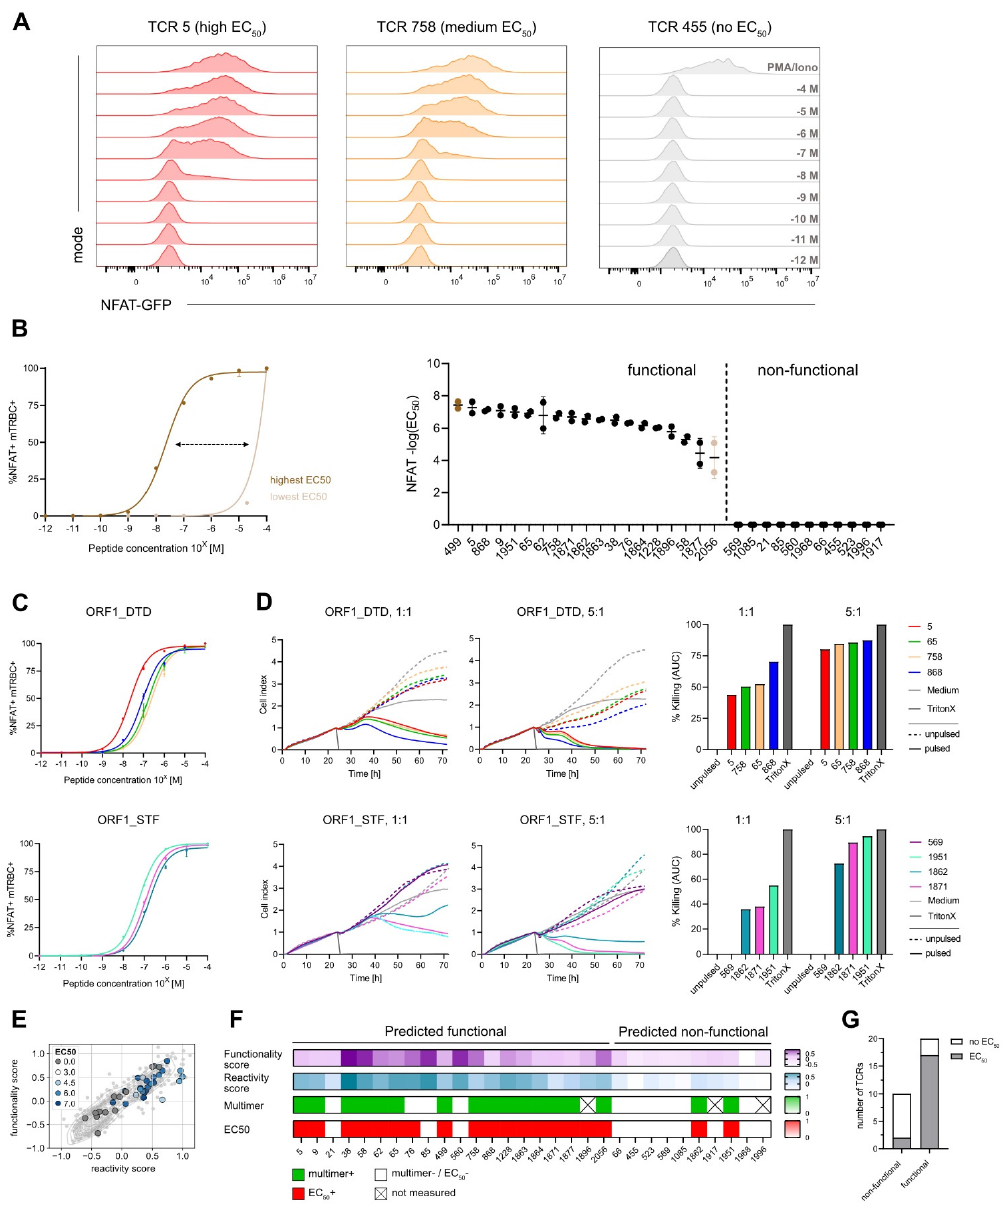
Figure 3. Gene signature scores identify functional TCRs. ( A ) Coculture assay of SARS-CoV-2- specific J-TPR-CD8 + cells with HLA-matched, peptide-pulsed K562 cells. MFI of NFAT signal according to peptide concentrations (10 − 4 M to 10 − 12 M) is shown representative of TCRs with high, medium, and low EC 50 values of NFAT-GFP. ( B ) Range of NFAT EC 50 values (left). Summary of NFAT EC 50 values ordered according to frequency. Functional and non-functional TCRs are delimited by a dashed line (right). Highest and lowest EC 50 value is colored dark brown and light brown, respectively. ( C ) Normalized mTRBC + NFAT + peptide titration curves of TCRs binding to epitopes ORF1_DTD (top) and ORF1_STF (bottom). ( D ) xCELLigence-based primary CD8 + T-cell killing assays with peptide-pulsed HLA-A*01 and HLA-A*11 A549 cells at E:T 1:1 and 5:1 for TCRs binding to epitopes ORF1_DTD and ORF1_STF (left). Quantification of killing as calculation of the area under the curve (right). ( E ) Gene signature scores overlapping with EC 50 scores. TCRs are color-coded according to EC 50 values. ( F ) Heat map of functionality and reactivity scores as a gradient, and pMHC multimer reactivity and measurable EC 50 value defined as positive or negative. ( G ) Quantification of non-functional and functional TCRs according to EC 50 values. AUC: Area under the